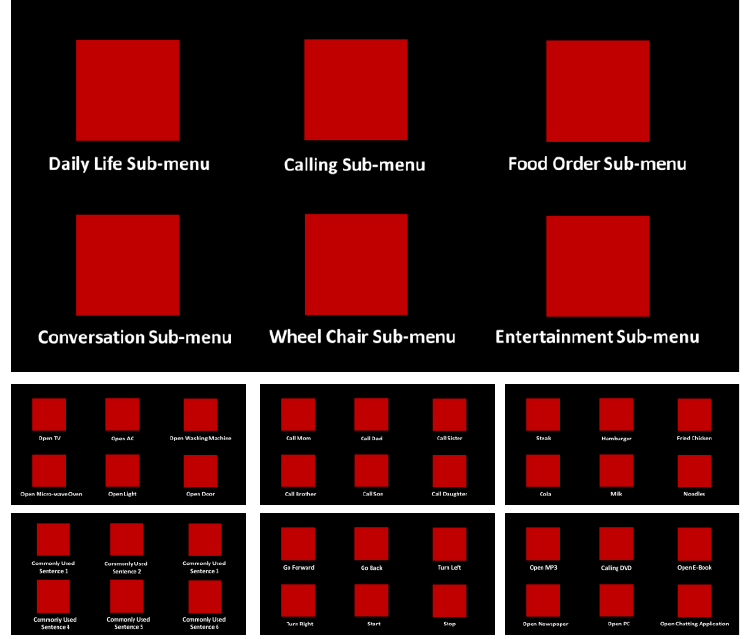
Figure 2. Interface for the selection menu.